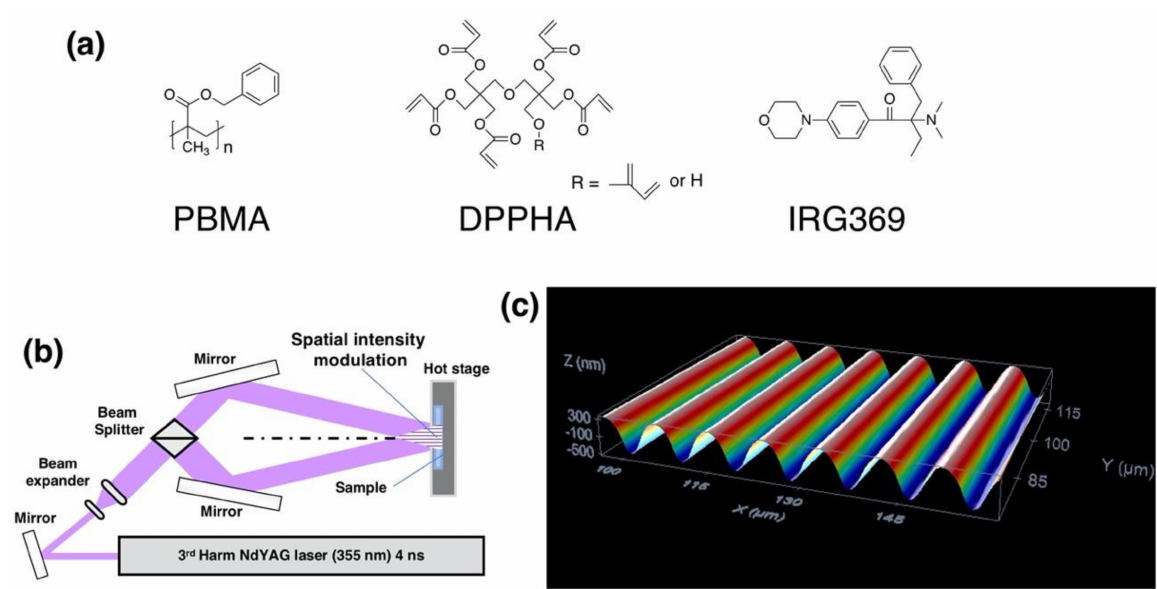
Figure 1. ( a ) Photopolymer components molecular structure. ( b ) Interference lithography setup. ( c ) Surface-relief topogra- phy of a 9 µ m period grating generated using IL setup and a conventional photoembossing protocol comprising an exposure step at RT (energy dose: 3.6 mJ/cm 2 ), followed by a heating step to high temperature (development temperature: 80 ◦